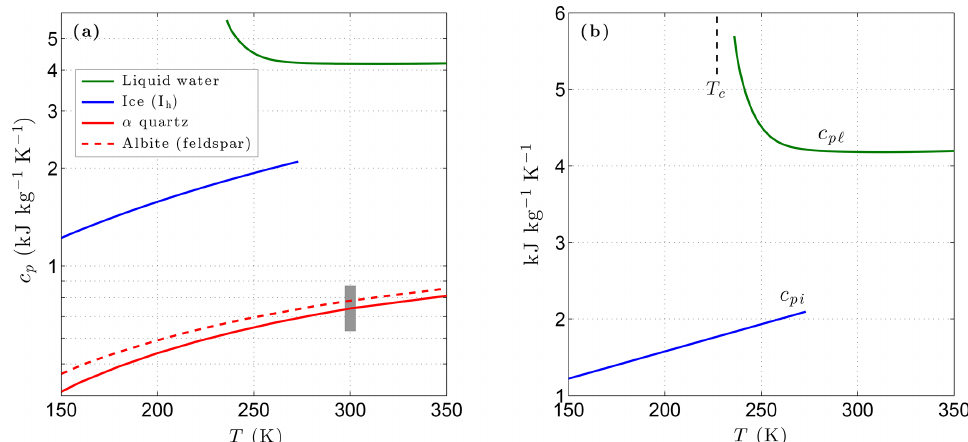
Figure 1. (a) Variation of the specific heat with temperature for liquid water, ice, and two common minerals (quartz, albite). The vertical grey bar shows the specific heat range for most minerals at 300K. Panel (b) shows the specific heat of liquid water and of ice in more detail. The vertical dashed line shows the temperature of the liquid–liquid critical point ( T c ).